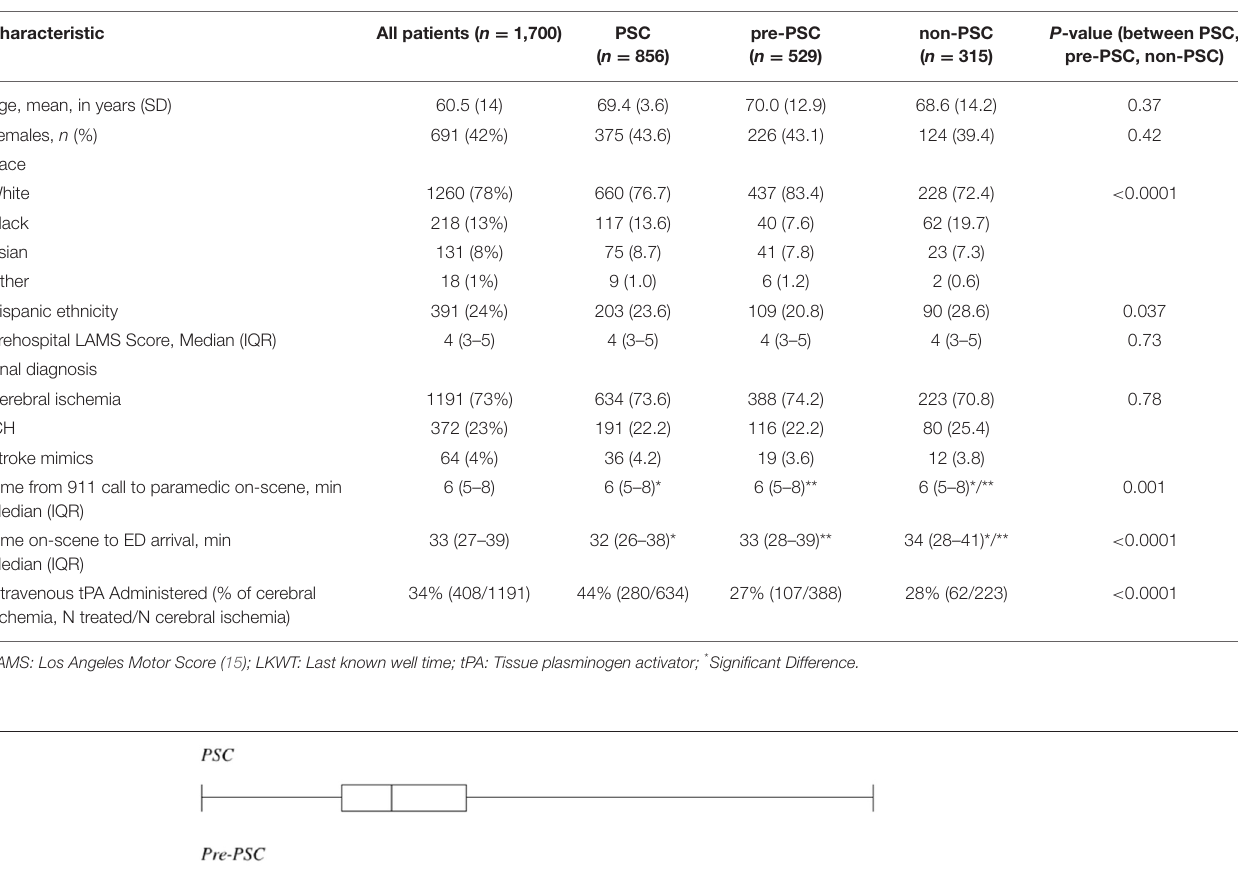
TABLE 2 | Patient characteristics of the overall FAST-MAG Study Population and PSC, pre-PSC, and non-PSC populations. Characteristic All patients ( n = 1,700) PSC